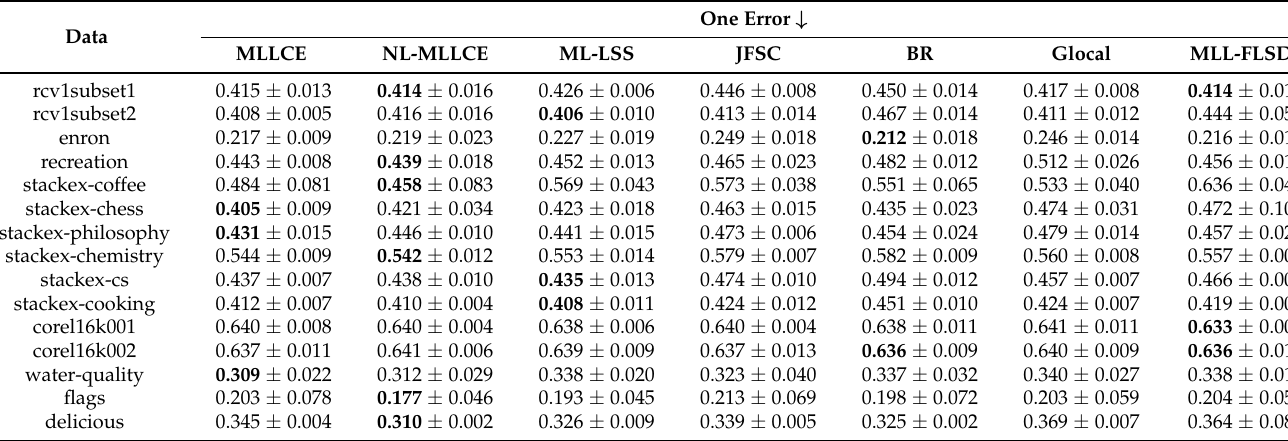
Table 4. The experimental results (mean ± standard) of all comparison methods in this paper in terms of One Error. ↓ means that the smaller the value, the better the performance is. The best results in each row are highlighted in bold face.